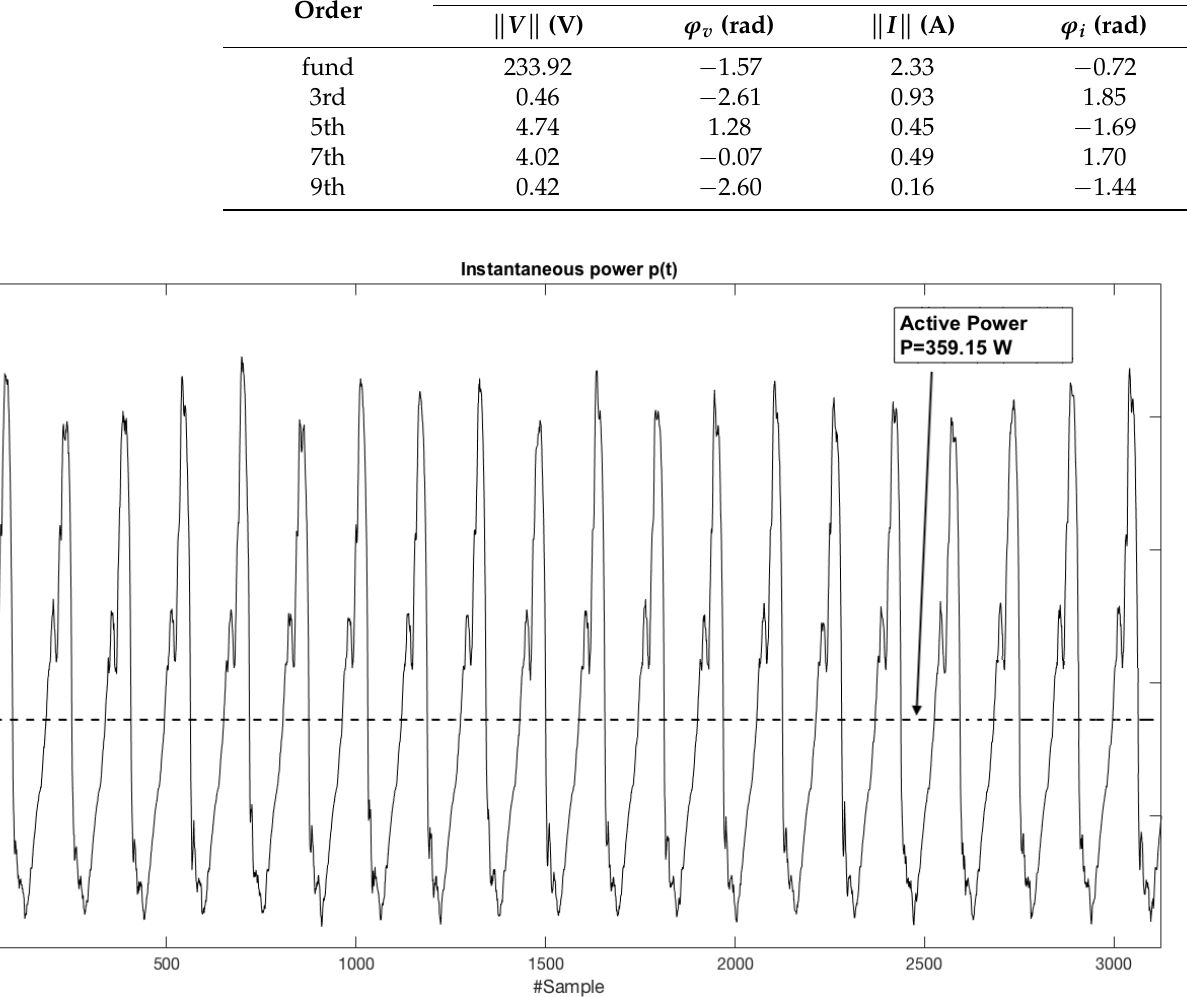
Figure 5. Instantaneous power waveform and active power P in Example